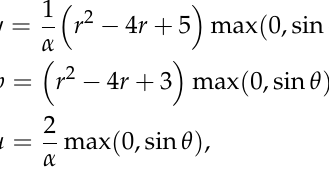
Table 2. Error of control u , state y and adjoint state p for experiment 2 with fixed L . ( a ) L 2 -norm